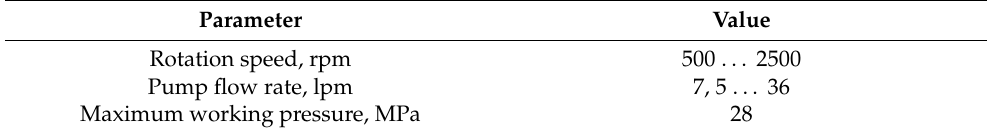
Table 2. Main technical data of the Rexroth AZPF-12-014 pump.